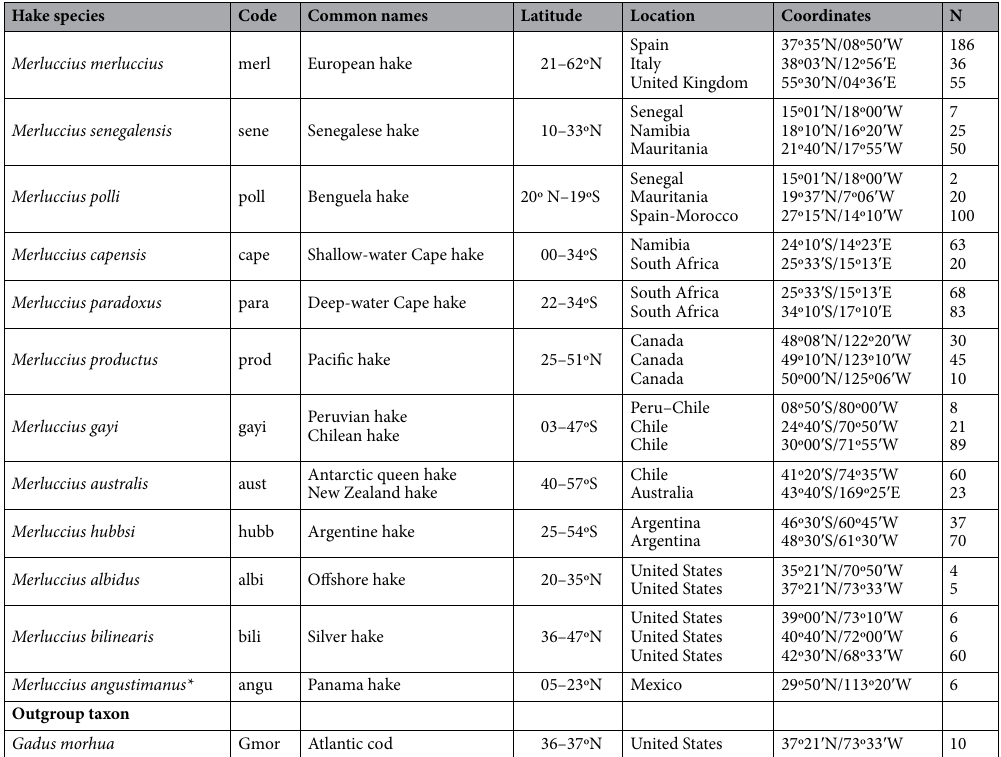
Table 1. Origin of hakes used in reconstructing the phylogenetic backbone of genus Merluccius spp. N is the number of specimens sampled per location. *The so-called M. hernandezi (California hake) in 33 .